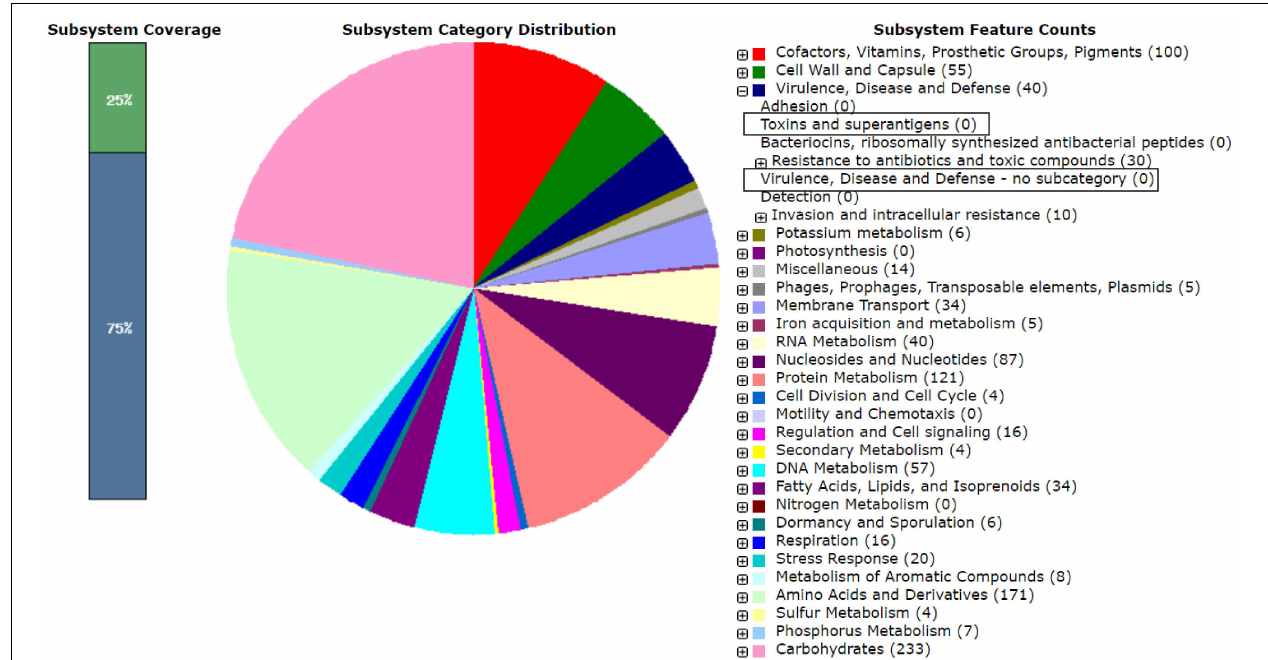
FIGURE 3 | RAST analysis on the genome sequence of the Lactiplantibacillus plantarum subsp. plantarum LB244R. The marked boxes show that no genes encoding toxins or virulence were found in the genome.